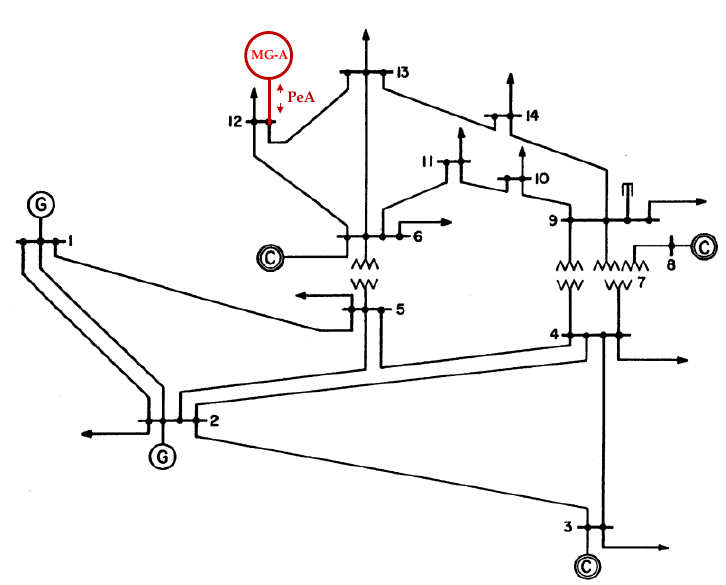
Figure 4. IEEE 14-bus test system with MG-A.